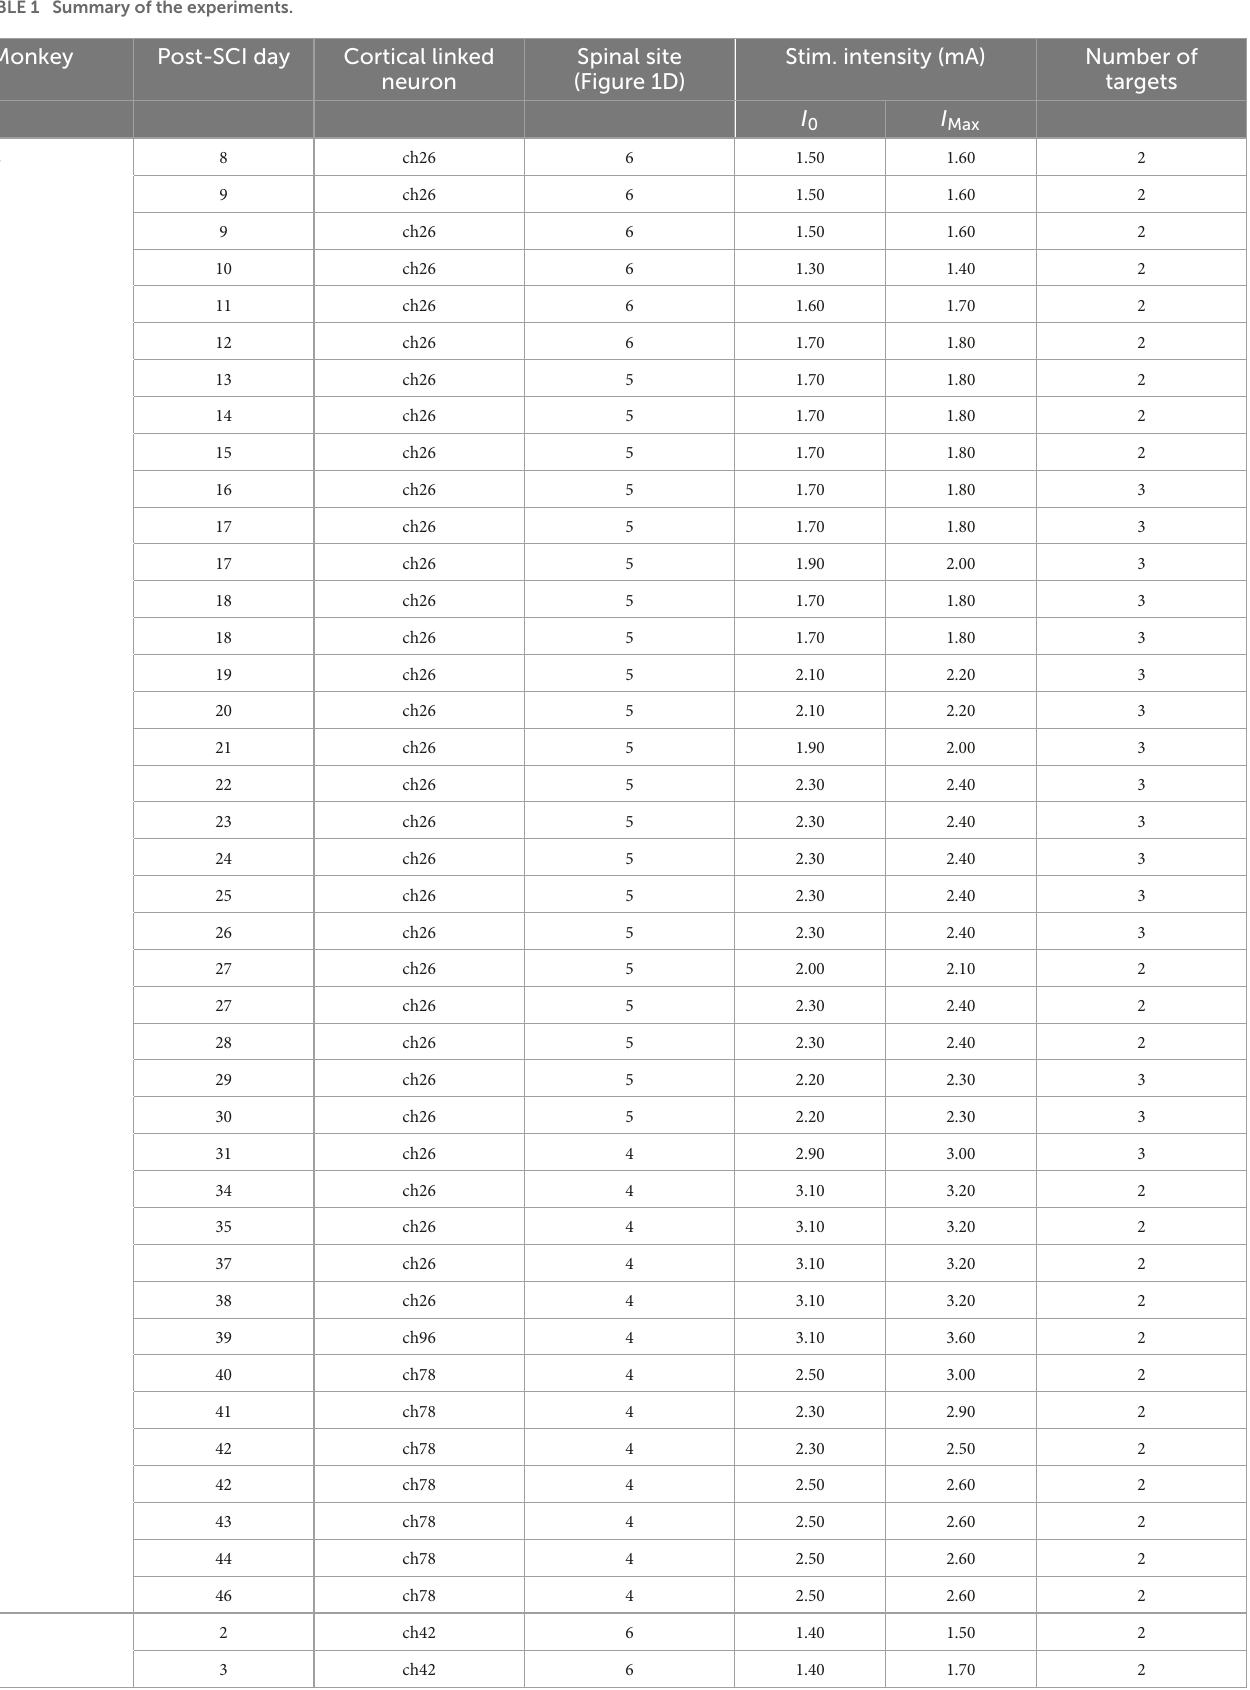
TABLE 1 Summary of the experiments. Monkey Post-SCI day Cortical linked